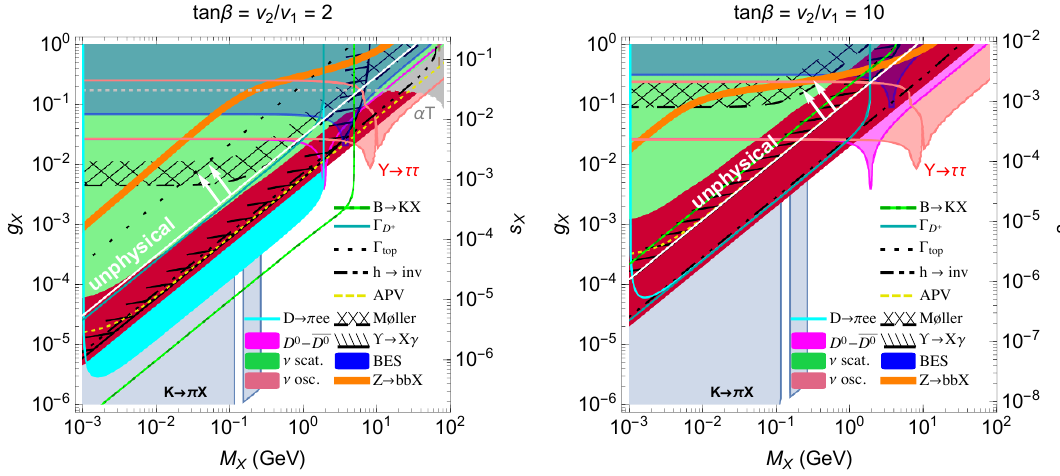
Figure 6. More complete list of constraints on the U(1) (3) gauge boson mass M X and coupling B (cid:0) L g X for tan (cid:12) = 2 ; 10. For convenience the X (cid:0) Z mixing, s X , is also shown. Notice that for a given g X , the mass of the gauge boson M X is bounded from below, so there is an unphysical region in the upper left corner of the M X (cid:2) g X plane (delineated by the white line). The \ (cid:23) scat" bound is a combination of all neutrino scattering experiments listed in the text, while \ (cid:23) osc." comes from non standard interaction e(cid:11)ects (matter potential) on atmospheric neutrinos. \APV" refers to atomic parity violation. Here the charged Higgs mass, relevant to the B ! KX constraint, is taken to be 1200